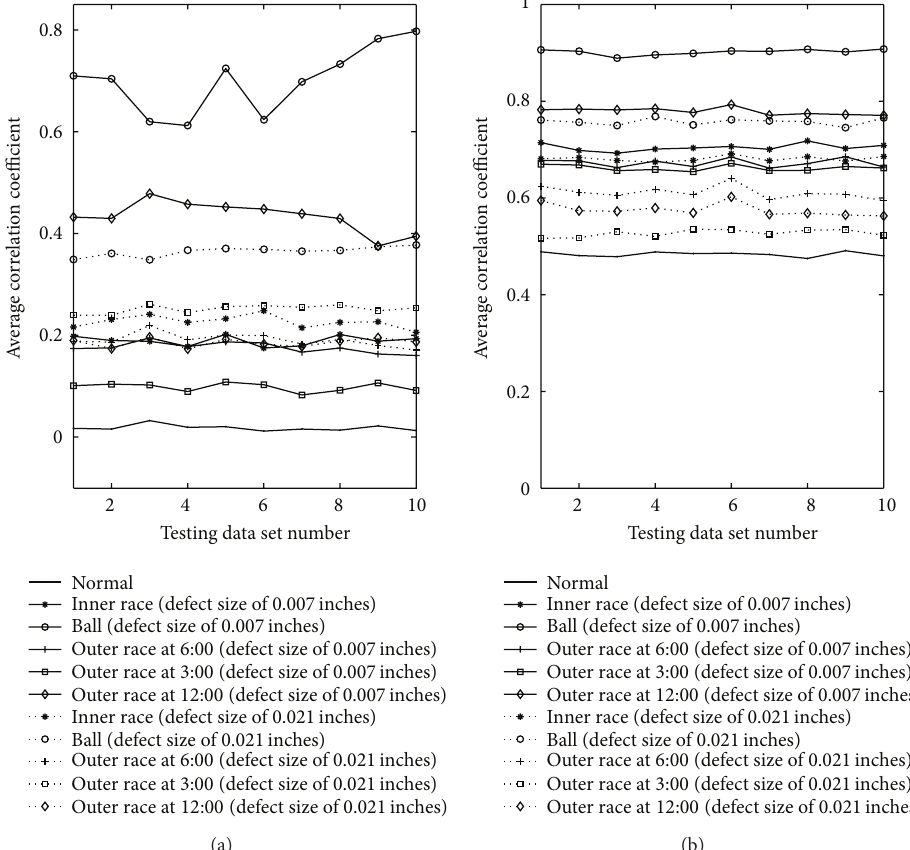
Figure 13: Detection results of ball fault with defect size of 0.007 inches according to morphology spectrum correlation analysis: (a) signal based triangular SE; (b) flat